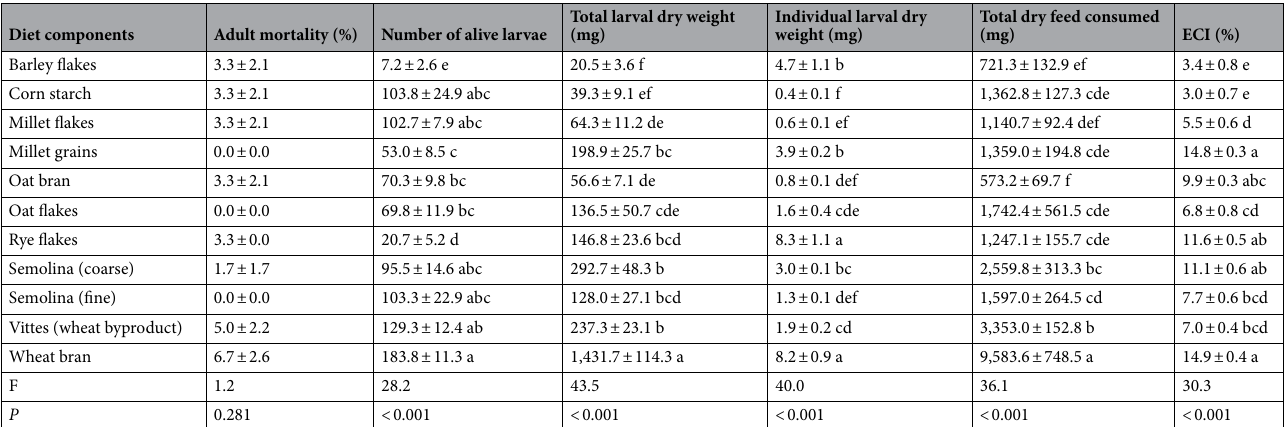
Table 4. Adult mortality (%) (after 1-week), number of alive larvae, total larval dry weight (mg), mean individual larval dry weight, total dry feed consumed (mg), and efficiency of ingested food conversion (ECI, %) of Tenebrio molitor larvae fed on various non-flour, cereal substrates for 10 weeks. In all cases, values represent means ± SEM (n = 6). Within each column, means followed by the same lowercase letter are not significantly different (in all cases df = 10, 65; Tukey–Kramer HSD test at P = 0.05. Where no letters exist, no significant differences were